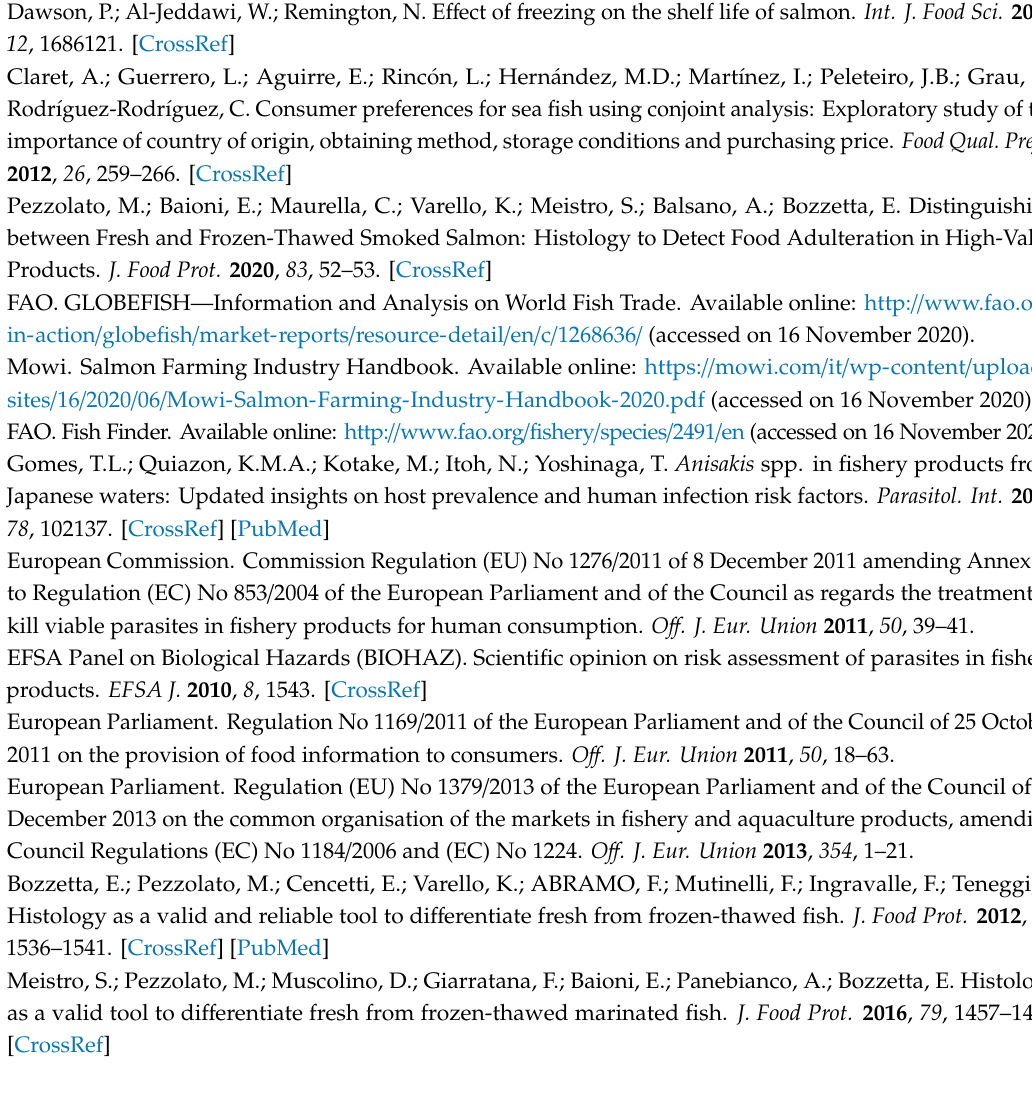
Figure S1: Workflow tree from the Compound Discoverer 3.1 software displaying select data processing nodes and the associated workflow connections. Figure S2: PCA projection on the distribution of fresh and pulled frozen / thawed salmon samples as regards PC-1 with PC-2 when HRMS spectral characterisation of normalised peak area was used. Figure S3: The most important alterations in relative content (normalized peak aria) of amino acids and some of their metabolites in fresh salmon samples with corresponding preservation method. Table S1: Identification and semi-quantification of the metabolites detected in salmon samples at T0 (mean ± SD; µ g / g IS equivalents). Table S2: Identification and semi-quantification of the metabolites detected in salmon samples at T10 (mean ± SD; µ g / g IS equivalents) Table S3: Identification and semi-quantification of the metabolites detected in the Bullet tuna sample (mean ± SD; µ g / g IS